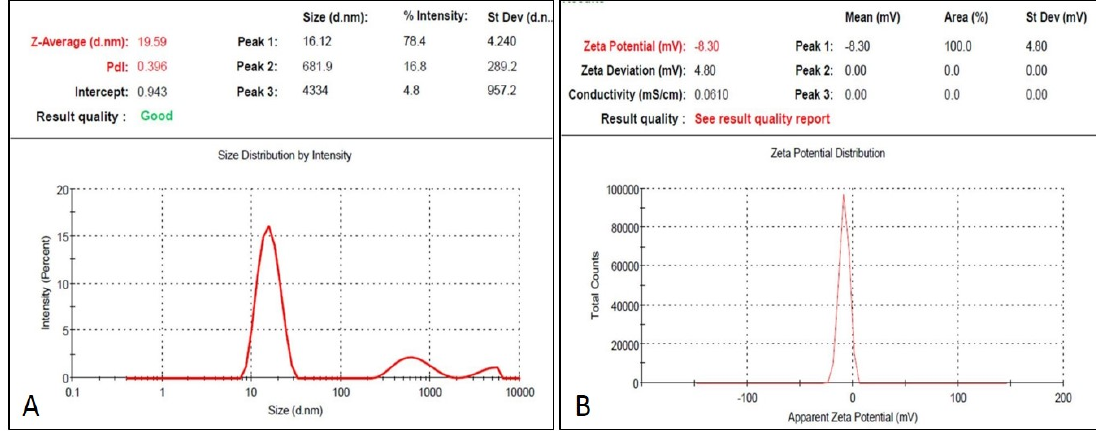
Figure 6. Dynamic light scattering (DLS) profile. ( A ) Size distribution of Asf-AgNPs (Asian spider flower-Silver nanoparticles) with maximum intensity at 19.59 nm, ( B ) Stable Asf-AgNPs at − 8.30 mV in zeta potential analysis.